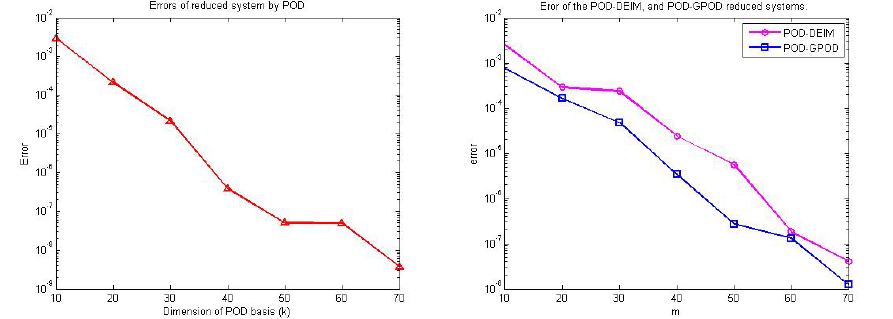
Figure 6. [Test 2] Average error plot of the approximation the POD, POD-DEIM, and POD-GPOD reduced systems with dimension of DEIM or nonlinear basis m